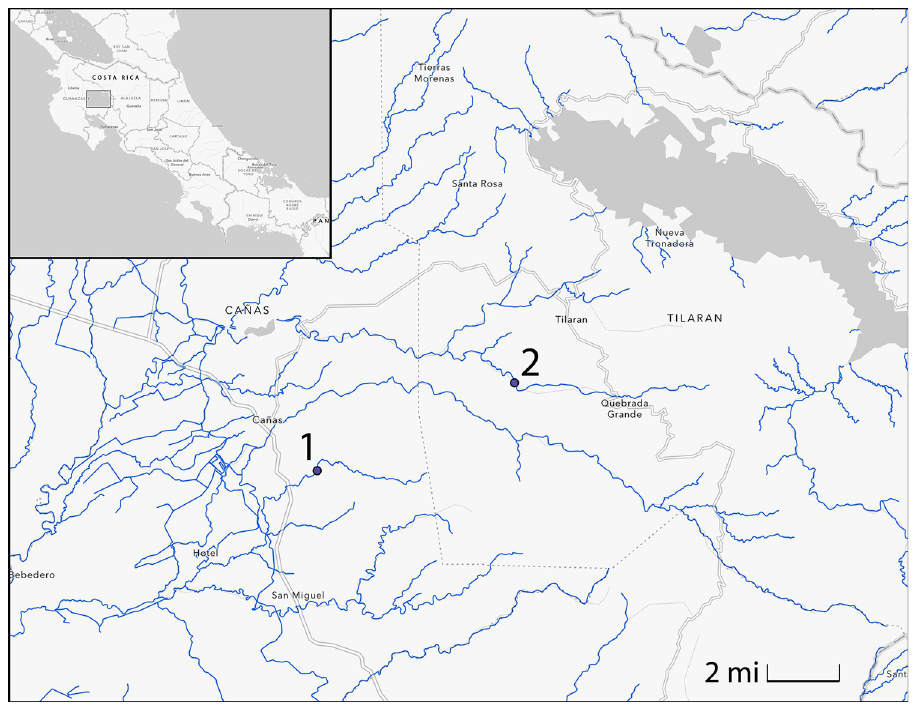
Fig 1. Sampling sites in Northern Costa Rica. 1) Rio Javilla (N10.40569, W-85.06948, elevation 112 m). 2) Quebrada Grande (N10.441976, W-84.98798, elevation 366 m). See Johnson & Belk [24] and Johnson [23] for additional details about these localities. This figure was generated in ArcGIS